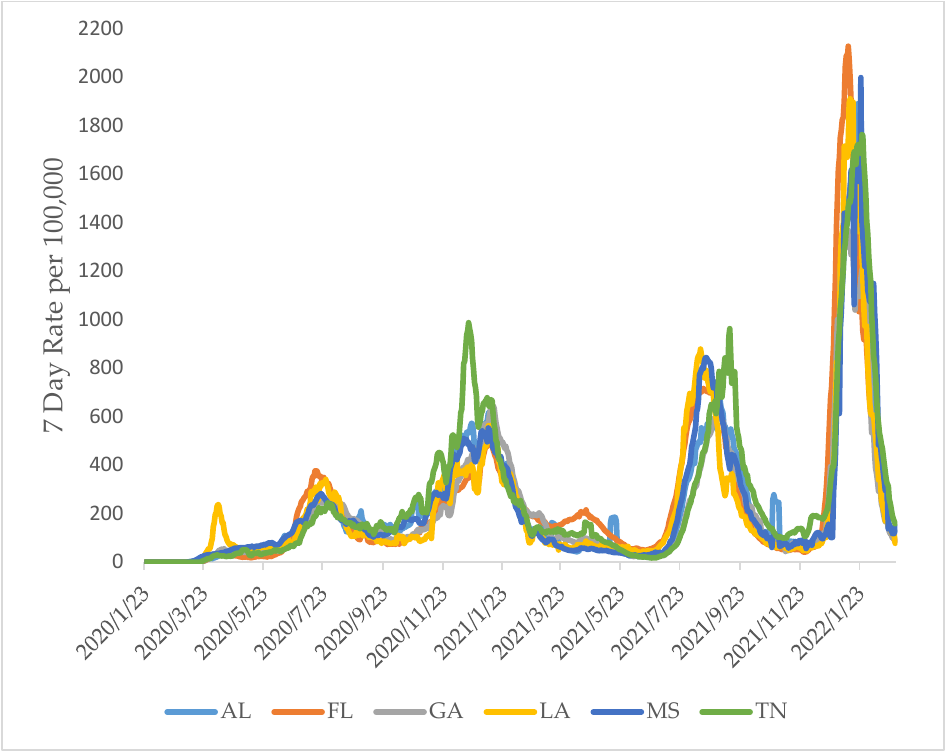
Figure 4. Time series analysis showing changes in the number of COVID-19 cases and related waves in the selected states from January 2020 through February 2022.